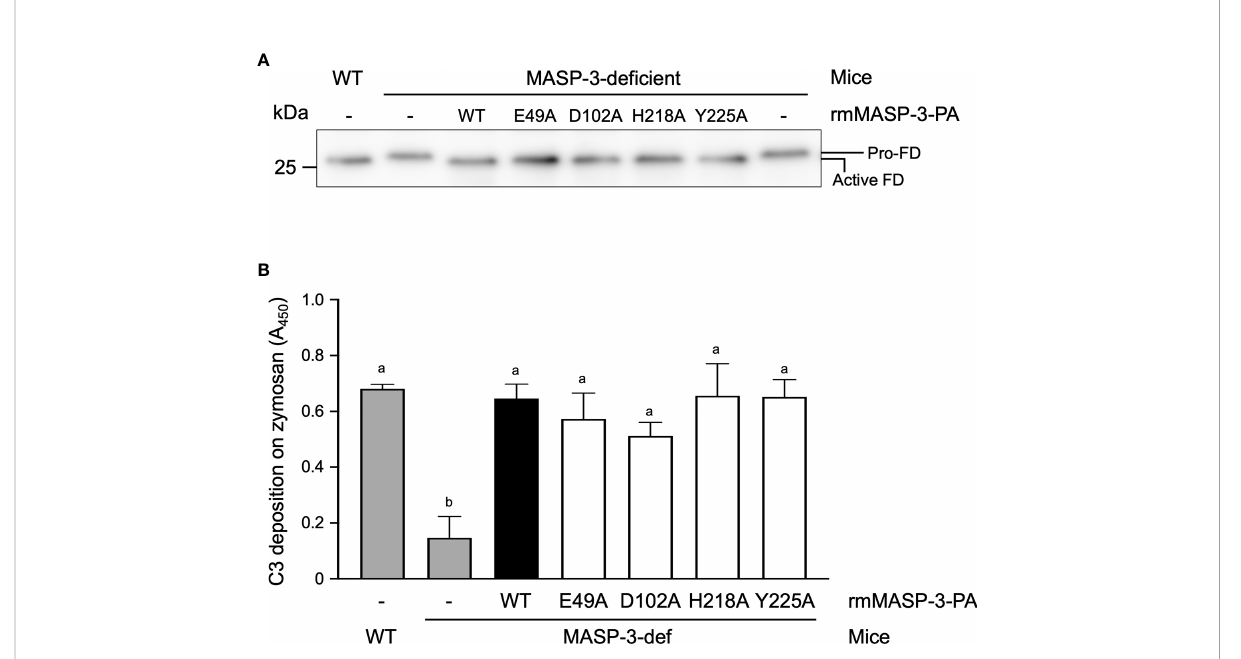
FIGURE 5 Restoration of the activation status of FD (A) and AP activity (B) in MASP-3-de fi cient mouse sera obtained 3 h after administrations of WT and mutant rmMASP-3-PAs. (A) Western blotting of FD was performed using serum samples that were preliminarily immunoprecipitated with anti- mouse FD antibody and then deglycosylated with N-glycosidase F. Pro-FD was detected at 26.1 kDa in MASP-3-de fi cient mouse sera (lane 2), while an active form FD was detected at a lower position (25.5 kDa; lane 1 and 3 – 7) than pro-FD. Similar results were obtained from three independent experiments, and a representative image is shown here. (B) The assay for the AP-driven serum C3 deposition activity was performed using a zymosan-coated microplate and TBS/Mg/EGTA under the Ca 2+ -chelated conditions. Values are means + SD ( n = 3) obtained by subtracting the absorbance at 450 nm of a control sample without mouse serum from the absorbance at 450 nm of each sample. Values not sharing the same letters are signi fi cantly different at P < 0.05, as analyzed by post-hoc Tukey ’ s multiple